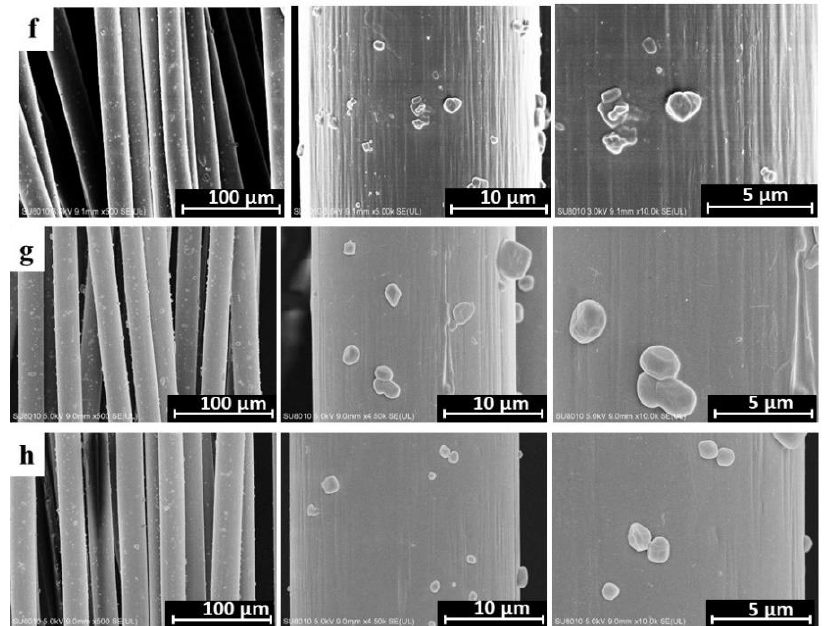
Figure 11. Scanning electron microscopy micrographs of the salt-confined nylon 6,6 fibres. The morphological cross-section structures of the 3% salt-confined nylon 6,6 ( a ) as-spun fibres, ( b ) drawn fibres — DR 4.5 HT120 ° C and ( c ) drawn fibres — DR 5.5 HT120 ° C. The morphological surfaces structures of the 3% salt-confined nylon 6,6 ( d ) as-spun fibres, ( e ) drawn fibres — DR 4.5 HT120 ° C, ( f ) drawn fibres — DR 5.5 HT120 ° C, ( g ) drawn fibres — DR 5.5 HT140 ° C and ( h ) drawn fibres — DR 5.5 HT160 ° C.